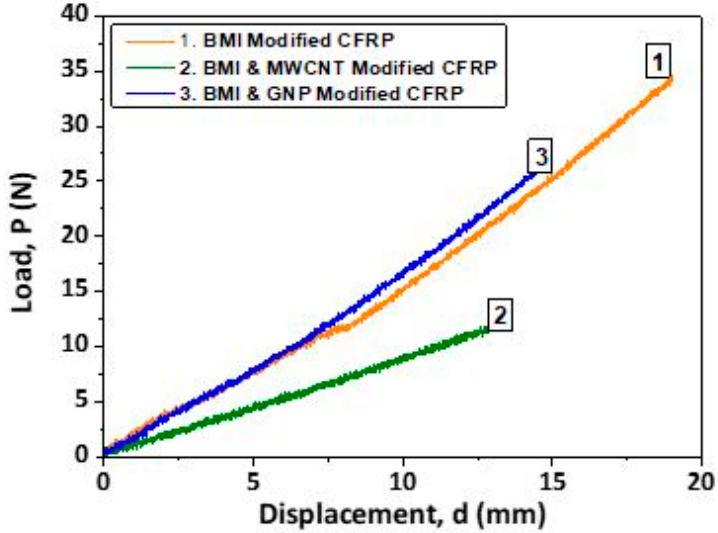
Figure 9. Typical load (P) versus displacement (d) curves for the reference and modified CFRPs